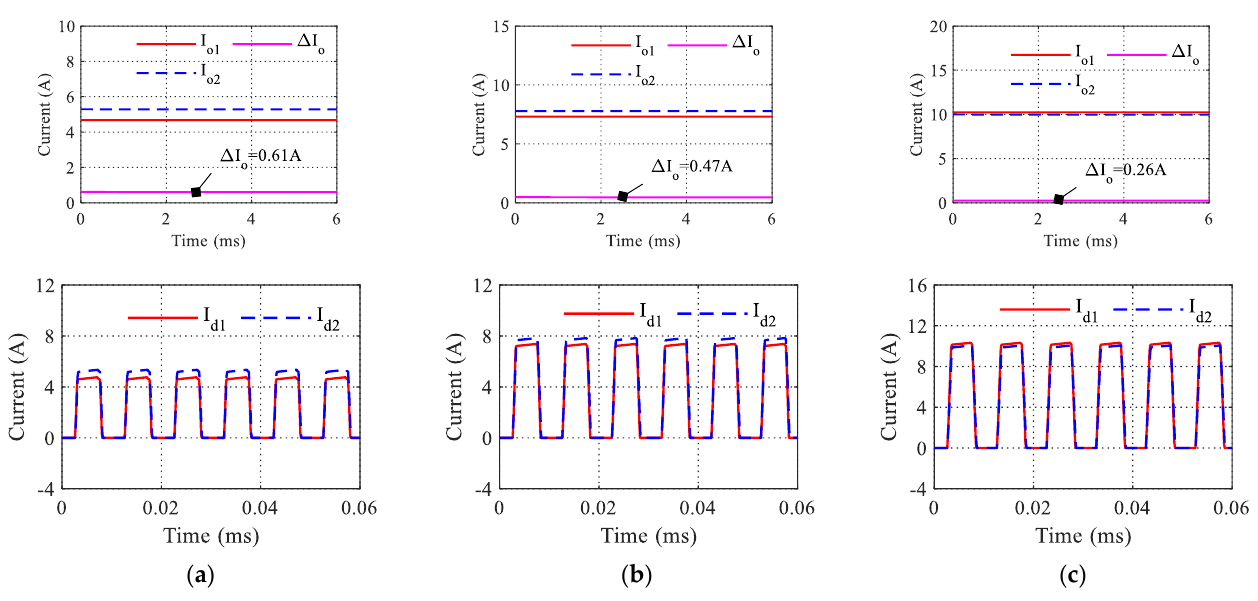
I and I in different P after using calculation result when a = o d o